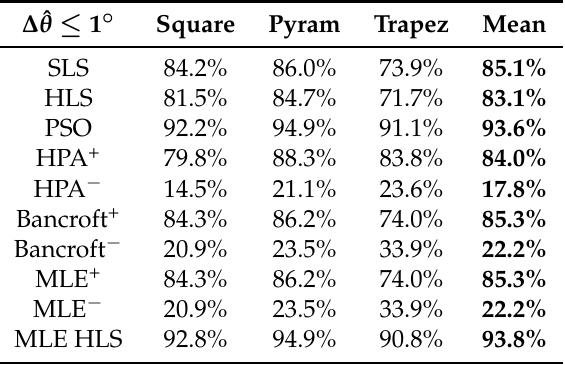
Table 7. Percentage of positions analysed located with an elevation angle error ∆ ˆ θ lower than 1 ◦ under digitizing error in time variables for each algorithm and antenna array configuration.